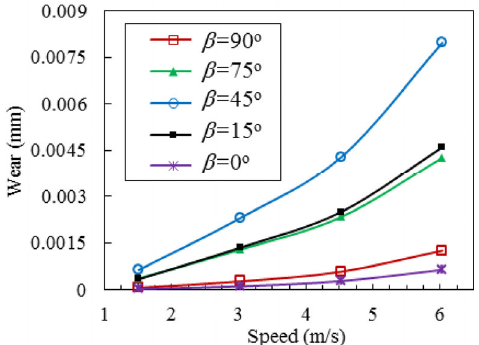
Fig. 17 Erosion versus the speed of the surface inside the particulate medium (the other parameters are at their reference values).